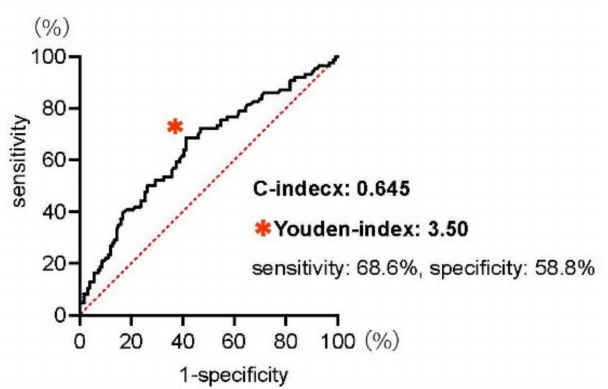
Figure 1. Receiver operating characteristic (ROC) curves for the neutrophil–lymphocyte ratio (NLR) at the initiation of pembrolizumab treatment for predicting one-year overall survival. The C-index was 0.645 (95%CI: 0.569–0.721), and the Youden index, the optimal cut–off value that maximizes the differences in sensitivity and specificity, was indicated at the *